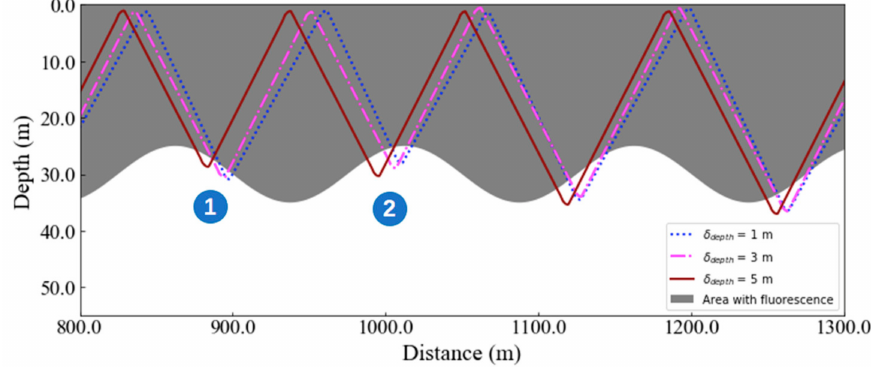
Figure 12. The depth of the glider under the control of a depth controller, which changed the maximum dive depth according to a simplified fluorescence field when δ depth was set as 1 m, 3 m, and 5 m, respectively.